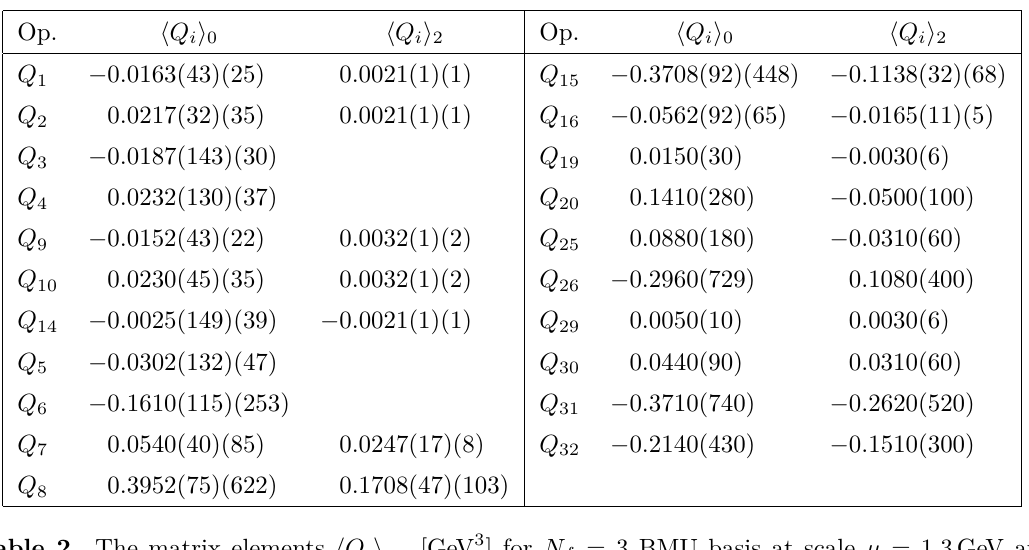
Table 2 . The matrix elements h Q shown. The statistical and systematic uncertainties are given for results from lattice